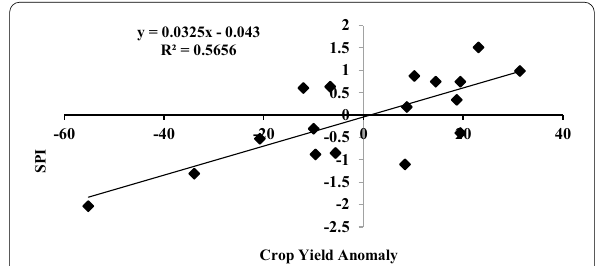
Fig. 14 Relation between SPI and Crop yield anomaly